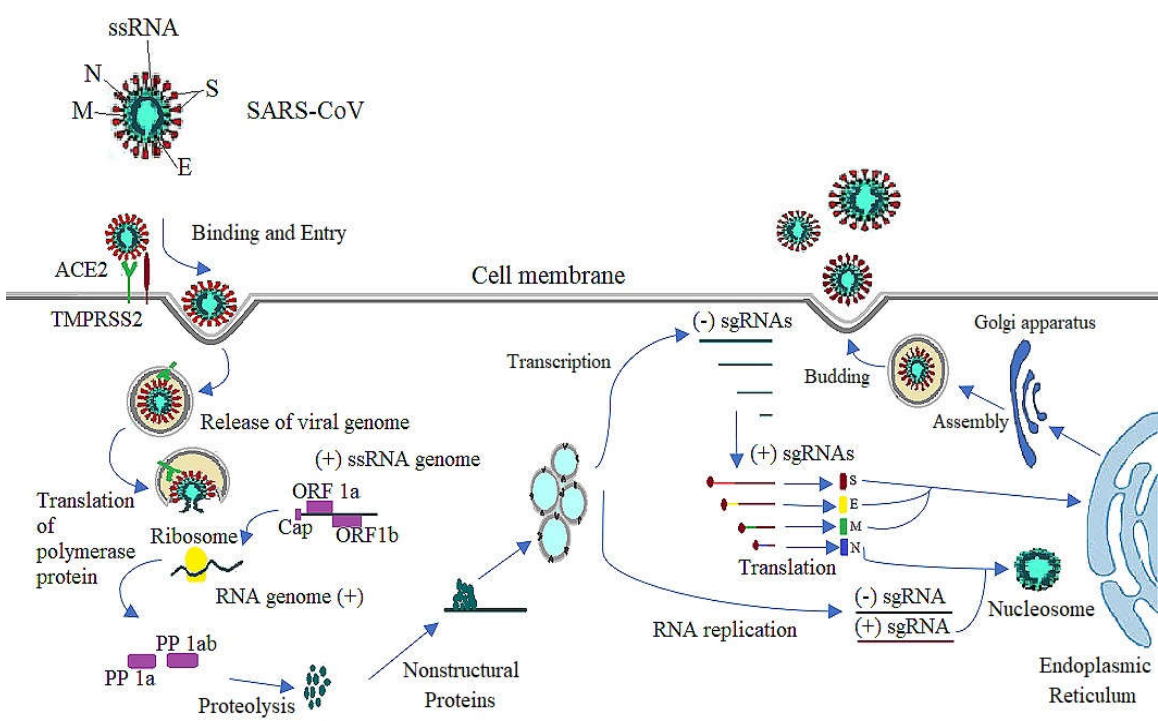
Fig 2. SARS-CoV-2 enters the host cell through the Spike protein (RBD/S1) attachment to the ACE2 receptor. In the cytosol, translation of ssRNA+ by host cell ribosome leads to the formation of the nonstructural polyproteins pp1a and pp1ab, which are proteolytically cleaved by a virus-encoded protease to form replicase complexes. The result of the complex activity is the formation of multiple gRNA copies and a set of sgRNAs. The sgRNA is translated into both structural and accessory proteins, which assemble into virus particles in the lumen of the ERGIC (Endoplasmic Reticulum Golgi Intermediate Compartment) and finally leave the contaminated cell by